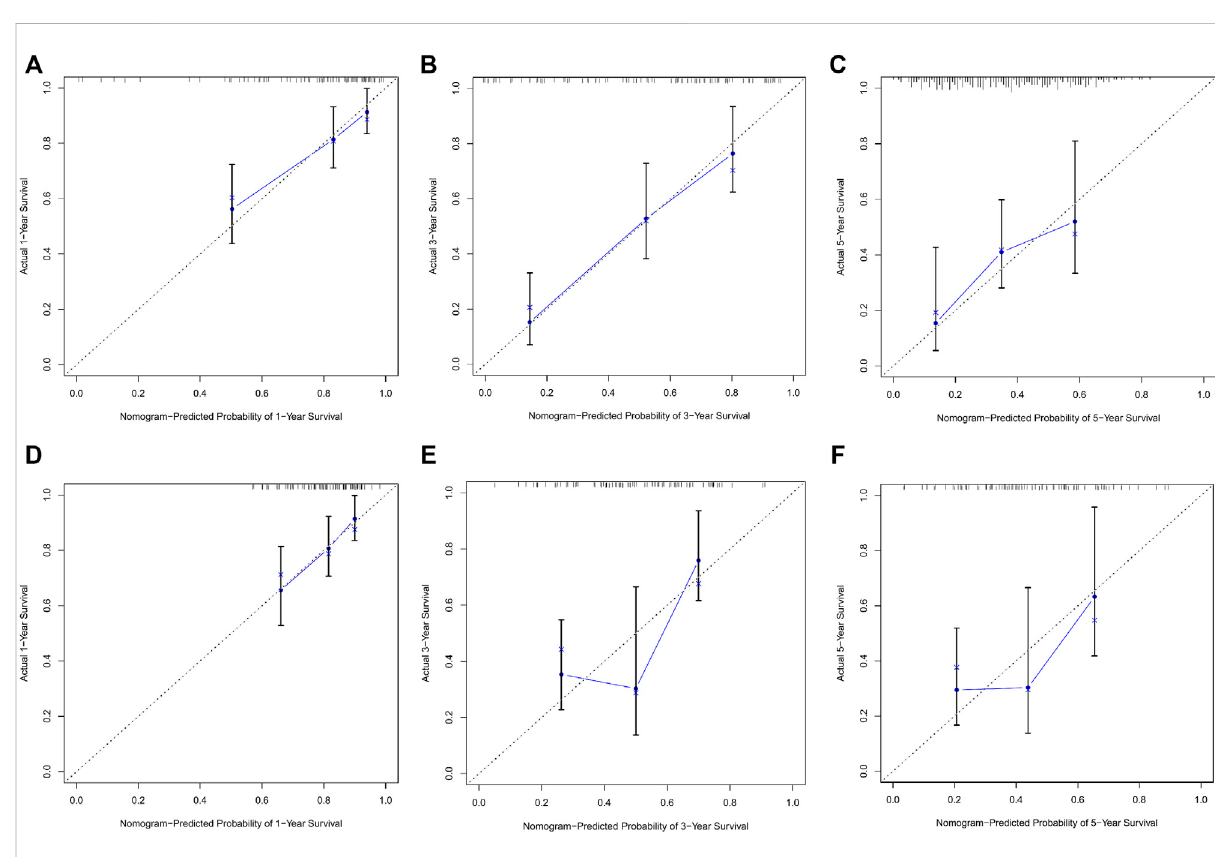
FIGURE 4 (A – C) Nomogramcalibrationplots to predict1-,3-, and5-year overall survival(OS)inthetraining cohort. (D – F) Nomogramcalibrationplotsto predict 1-, 3-, and 5-year overall survival (OS) in the validation cohort.